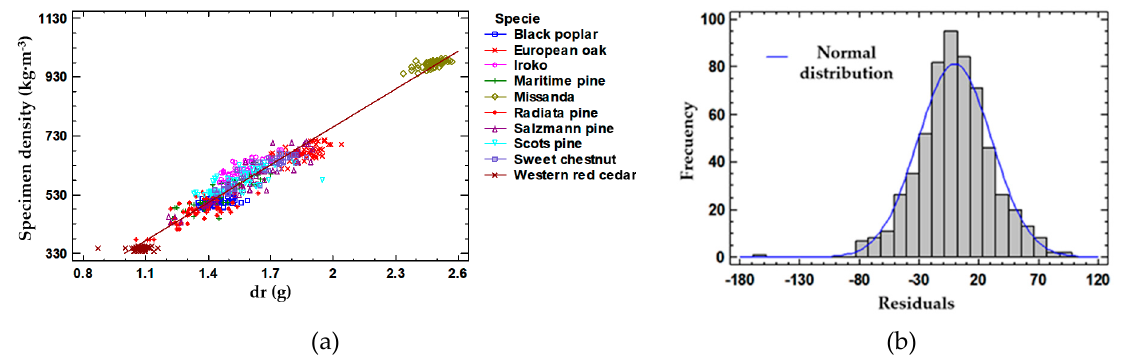
Figure 7. Linear regression between specimen density and drill residue mass. ( a ) Plot of the fitted model; ( b ) Frequency histogram of the model residuals.